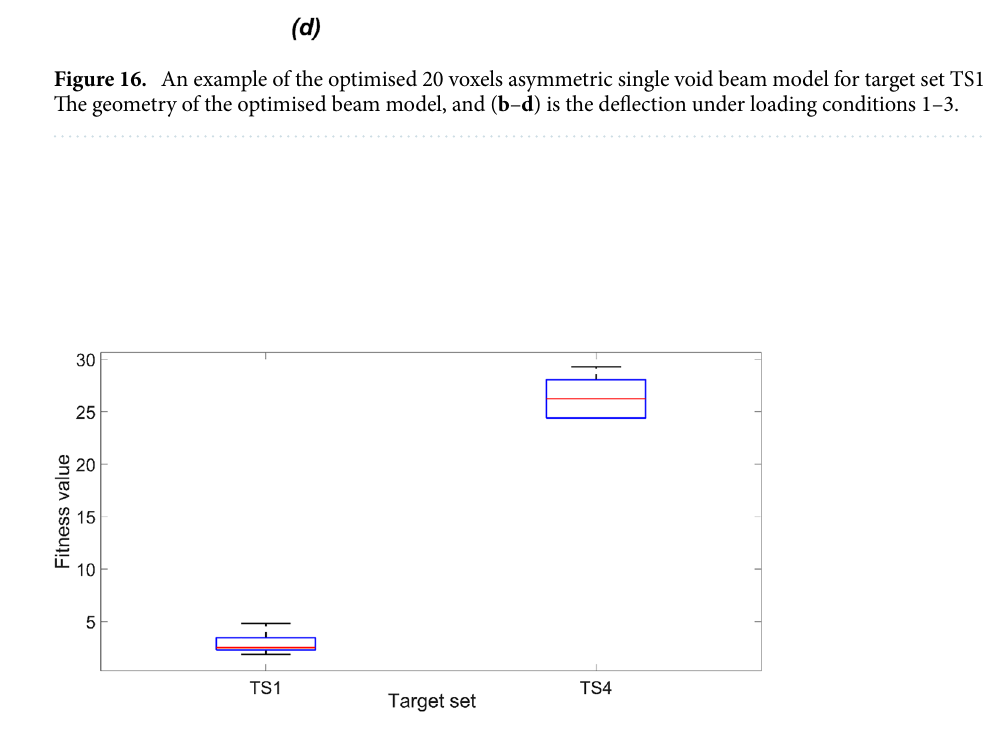
Figure 17. Comparison of fitness values for 20 voxel asymmetric single void beam model for target deflection sets TS1 and TS4. Each box plot represents the results of 5 trials for each target set. The lower the fitness value, the closer the obtained deflection sets were to the target deflection set. The solid lines in the middle indicate the median fitness values, the top and bottom of the boxes represent the 25th and 75th